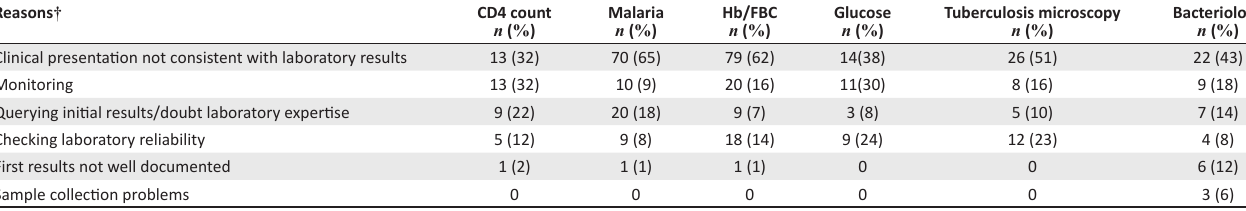
TABLE 3: Reasons given by clinicians in Malawi for repeating tests, October-November 2012.